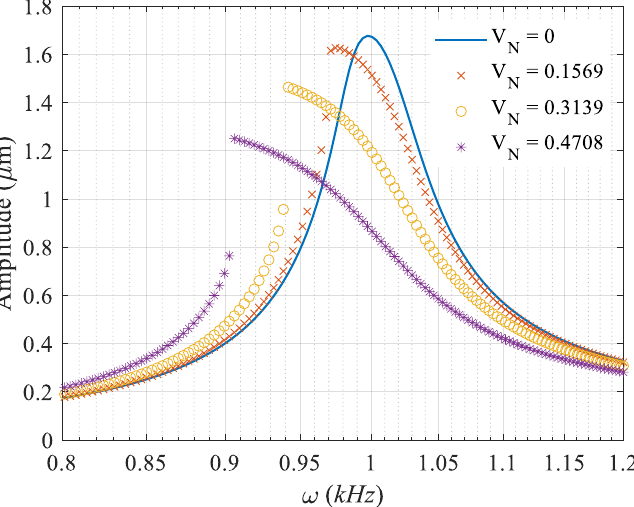
Figure 3. The frequency response curves with various DC Voltages.